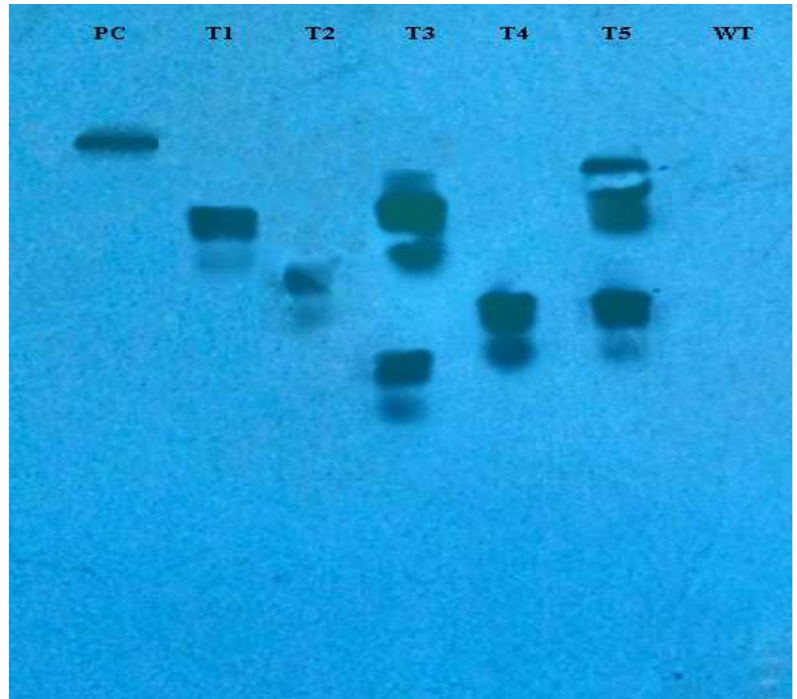
Figure 3. Southern blot analysis of PCR-positive plants demonstrating the incorporation of rol A gene into the Artemisia carvifolia genome. Transgenic lines T3 and T4 showed two copies of integrated gene.